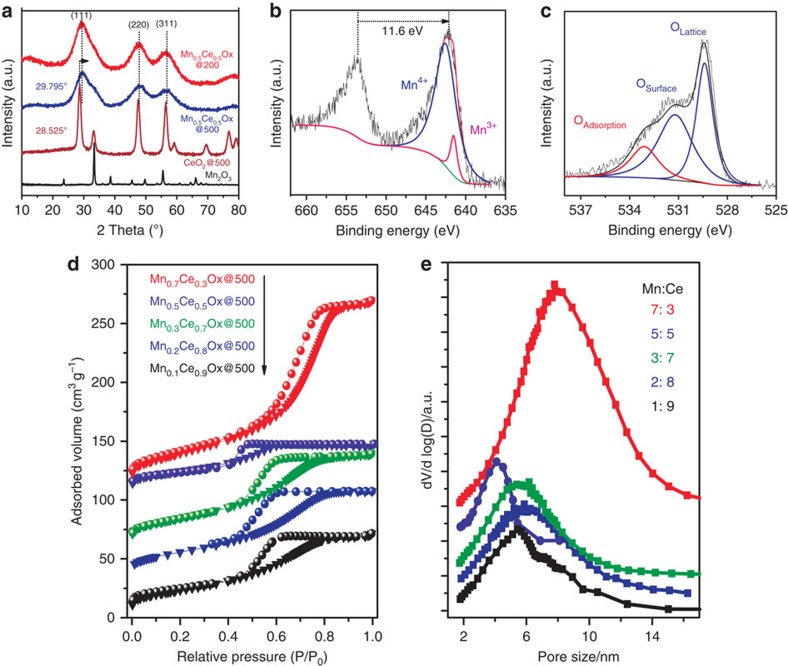
Structural characterizations of catalysts.(a) XRD patterns of Mn0.5Ce0.5Ox@200, Mn0.5Ce0.5Ox@500, CeO2@500 and Mn2O3. (b) XPS spectra of Mn 2p and (c) XPS spectra of O 1s of Mn0.5Ce0.5Ox@500. (d) N2 sorption isotherm curves of MnyCe1−yOx@500 samples at 77 K; For clarity, the isotherm curves for Mn0.2Ce0.8Ox@500, Mn0.3Ce0.7Ox@500, Mn0.5Ce0.5Ox@500 and Mn0.7Ce0.3Ox@500 were offset by 30, 60, 105 and 105 cm3 g−1, respectively. (e) pore size distributions of MnyCe1-yOx@500 samples.